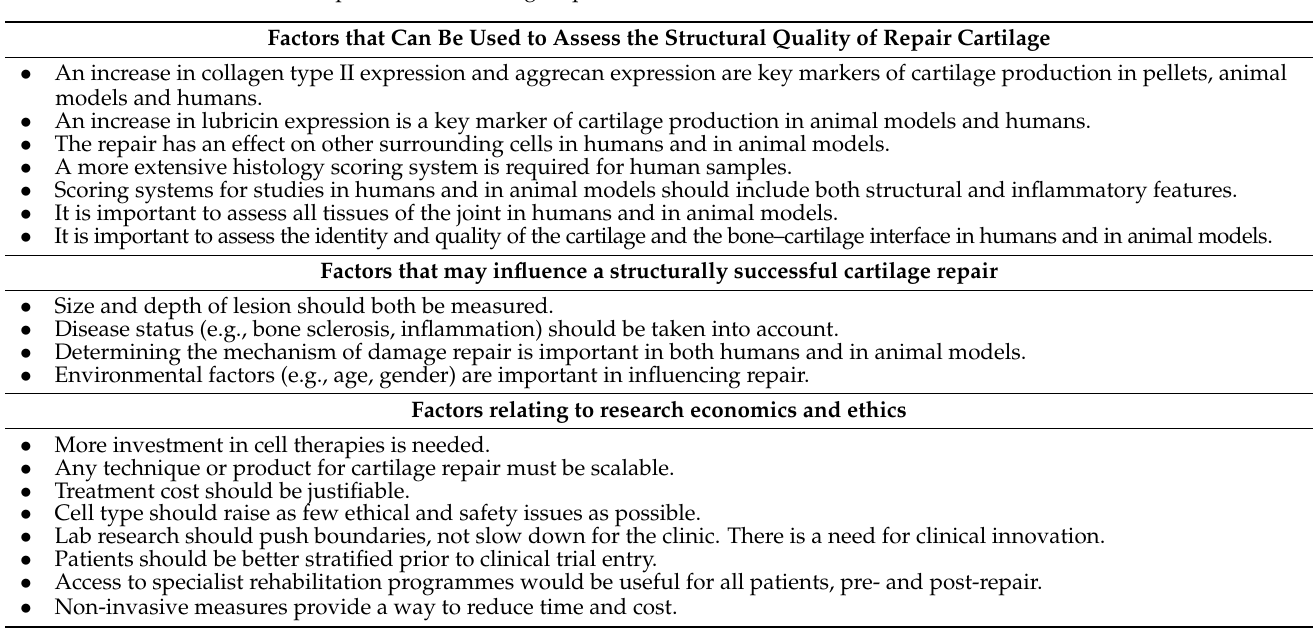
Table 4. A summary of the Likert-scale-rated single statements that can be used as guidelines by which to assess the structural quality of repair cartilage, those factors that could influence a successful cartilage repair and those that consider the economic and ethical implications of cartilage repair.